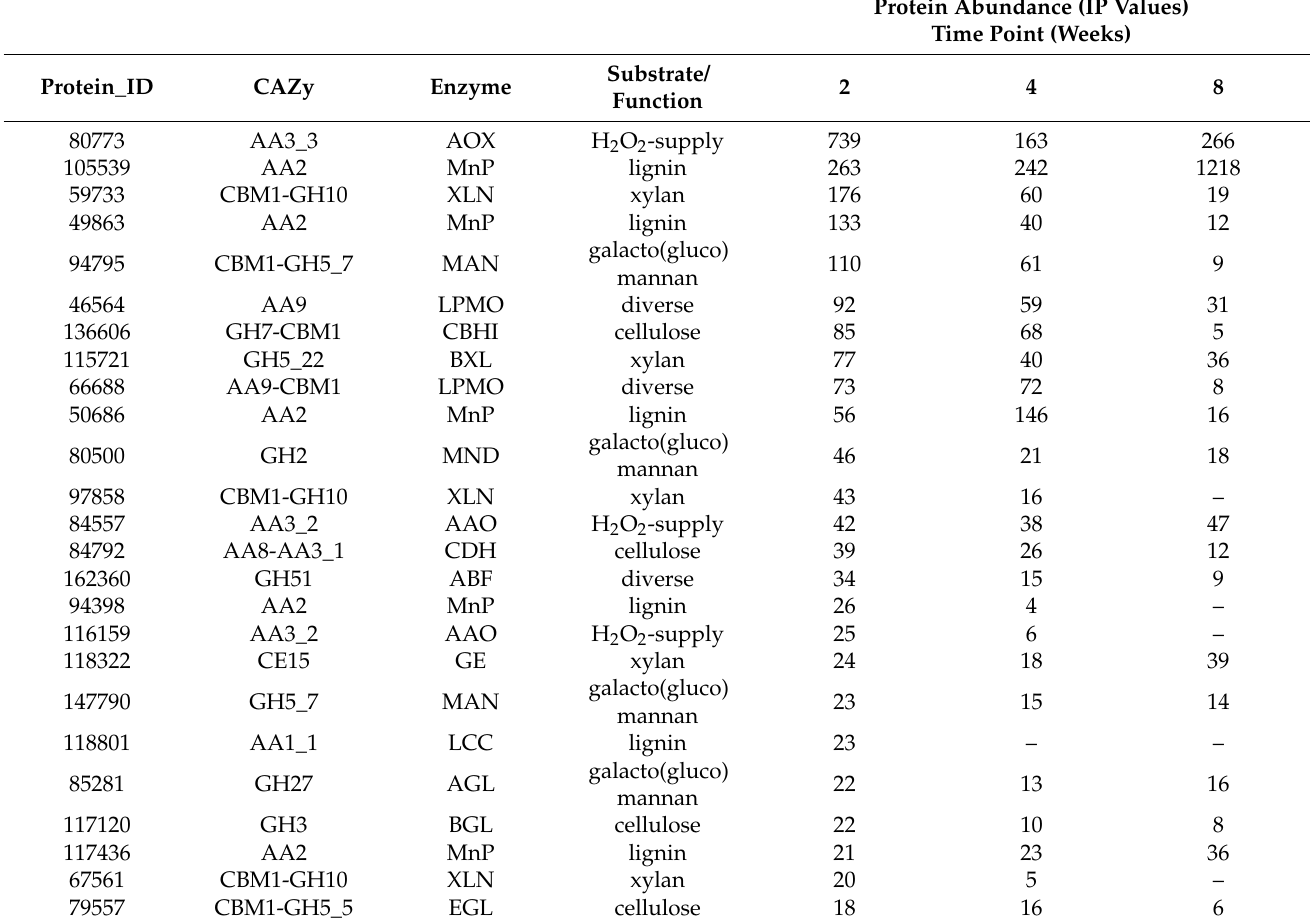
Table 1. The 25 most abundant plant cell wall degrading CAZymes produced by G. subvermispora during growth on solid spruce wood. IP values = ion profile values. Protein IDs assigned by JGI MycoCosm (https://mycocosm.jgi.doe.gov/Cersu1/Cersu1.home.html, accessed 5 April 2022). Enzyme abbreviations are presented in Supplementary Table